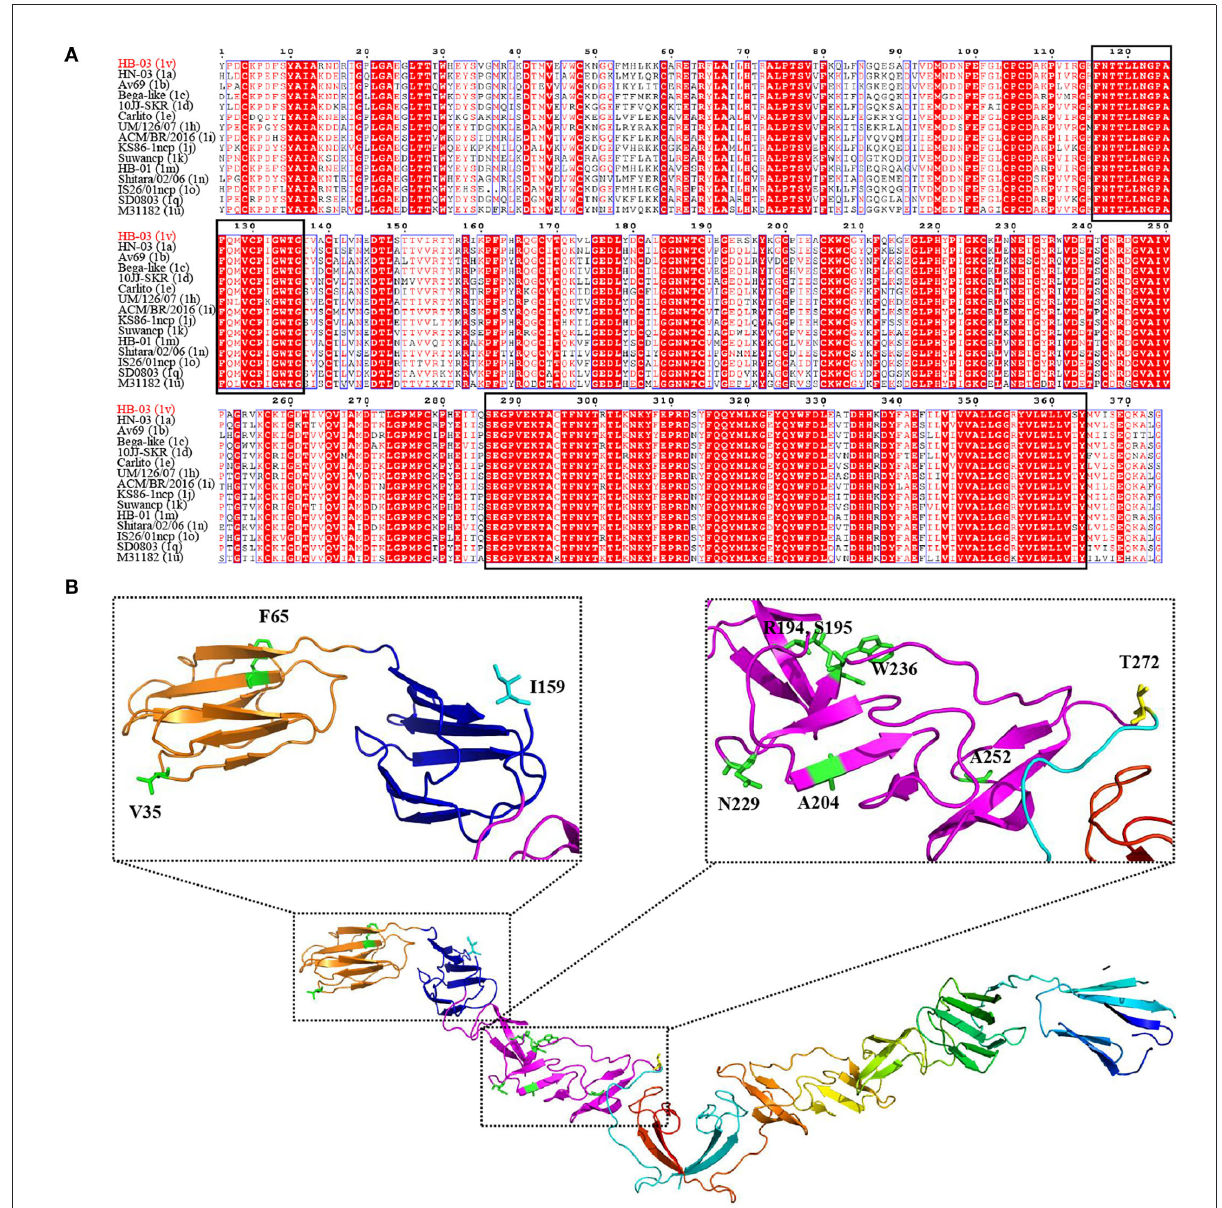
FIGURE7 Unique mutation analyses in the E2. (A) Sequence alignment of BVDV E2 sequences. Two highly conserved regions within the E2 sequence were revealed to locate at the amino acid positions of 116–136 and 286–364, respectively (black rectangle). (B) The cartoon schemes of the BVDV-1v HB-03 strain E2 protein structure. The domains of BVDV E2 modified from El Omari et al. (35). Domain DA, comprising residues 4–87, is in orange, and domain DB, comprising residues 88–164, is in blue. Domain DC, comprising residues 165–271, is in light purple, and domain DD, comprising 272–333, is in dark fluorescent